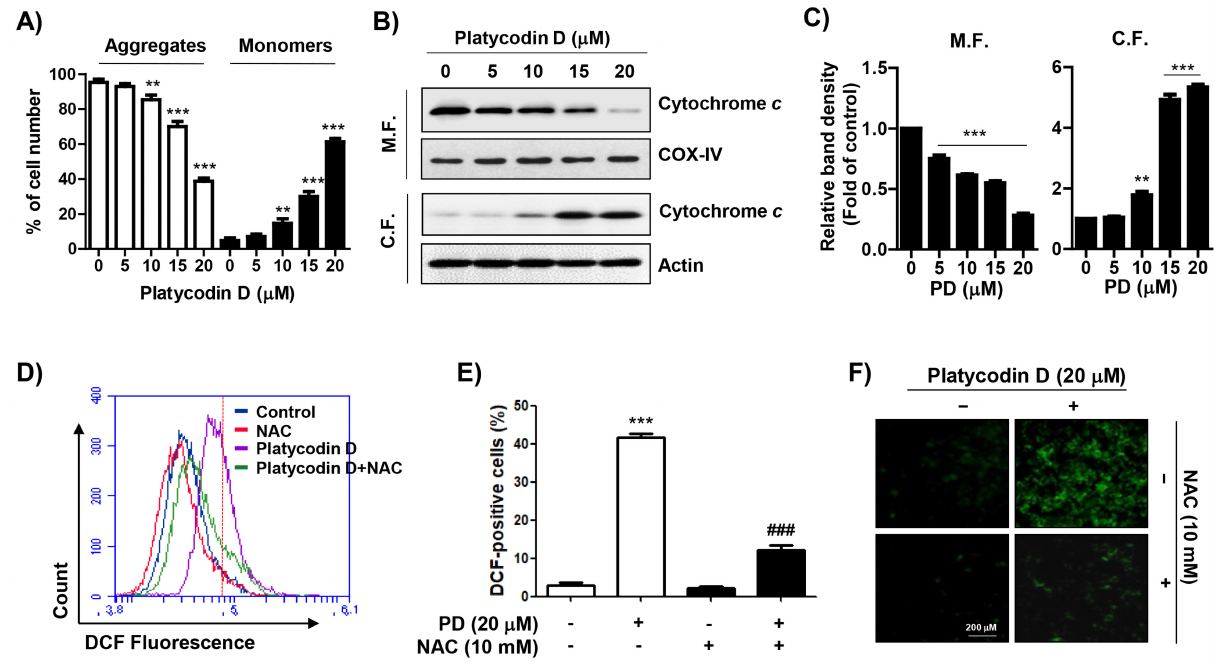
Fig. 4. Induction of mitochondrial dysfunction, cytosolic release of cytochrome c and ROS generation by PD in PC3 cells. (A) After treatment with PD, the cells were stained with JC-1 and then changes of MMP were determined by a flow cytometer. The data indicated the mean ± SD of three independent experiments ( ∗∗ P < 0.01 and ∗∗∗ P < 0.001 compared to untreated cells). (B) Expression levels of cytochrome c using cytoplasmic and mitochondrial fractions were investigated by Western blot analysis. Actin and cytochrome oxidase subunit VI (COX VI) in each protein extract were presented as loading controls. (C) The expression of cytochrome c was indicated as fold change with control. Each bar indicated the mean ± SD of three independent experiments ( ∗∗ P < 0.01 and ∗∗∗ P < 0.001 compared to untreated cells). (D–F) The cells were stimulated with 20 µ M PD for 1 h or incubated with or without 20 µ M PD for 1 h before treatment with 10 mM NAC for 1 h. (D and E) After removal of the medium, the cells were incubated with medium containing DCF-DA for 20 min. (D) The levels of intracellular ROS generation were determined by a flow cytometer. (E) The data represents the mean ± SD of three independent experiments (n = 6, ∗∗∗ P < 0.001 compared to control; ### P < 0.001 compared to PD-treated cells). (F) Fluorescence images were taken with a fluorescence microscope. The fluorescent images were taken with a fluorescence microscope (200 ×